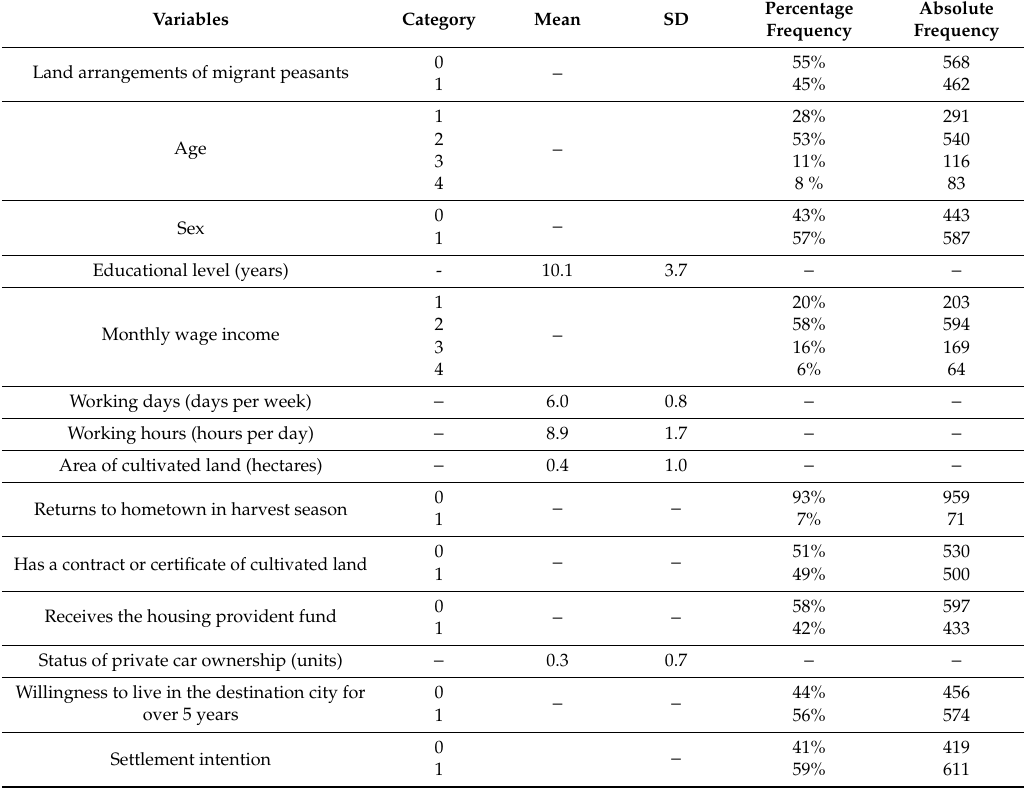
Table 2. Descriptive statistics of